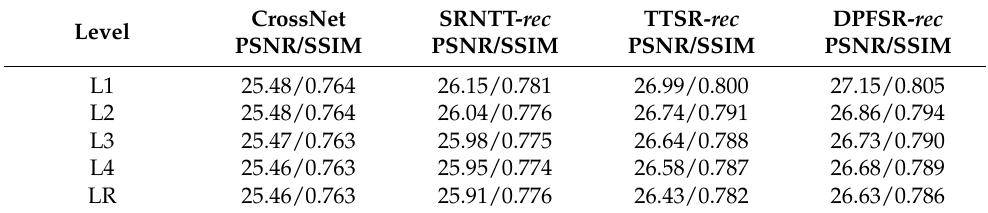
Table 4. Ablation study on reference images with five different similarity levels.